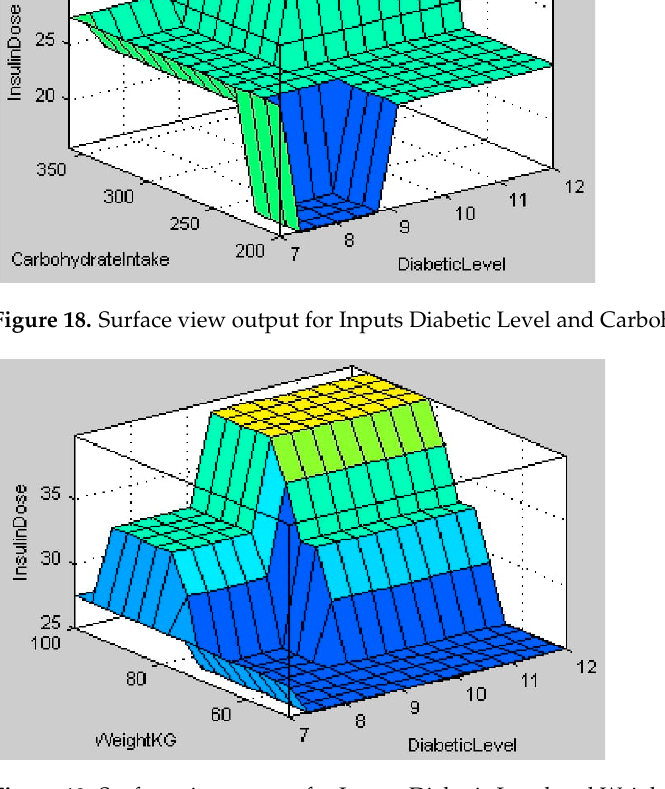
Figure 19. Surface view output for Inputs Diabetic Level and Weight.